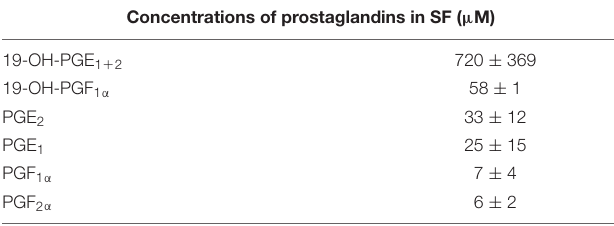
TABLE 2 | Prostaglandin concentrations in SF. Concentrations of prostaglandins in SF ( µ